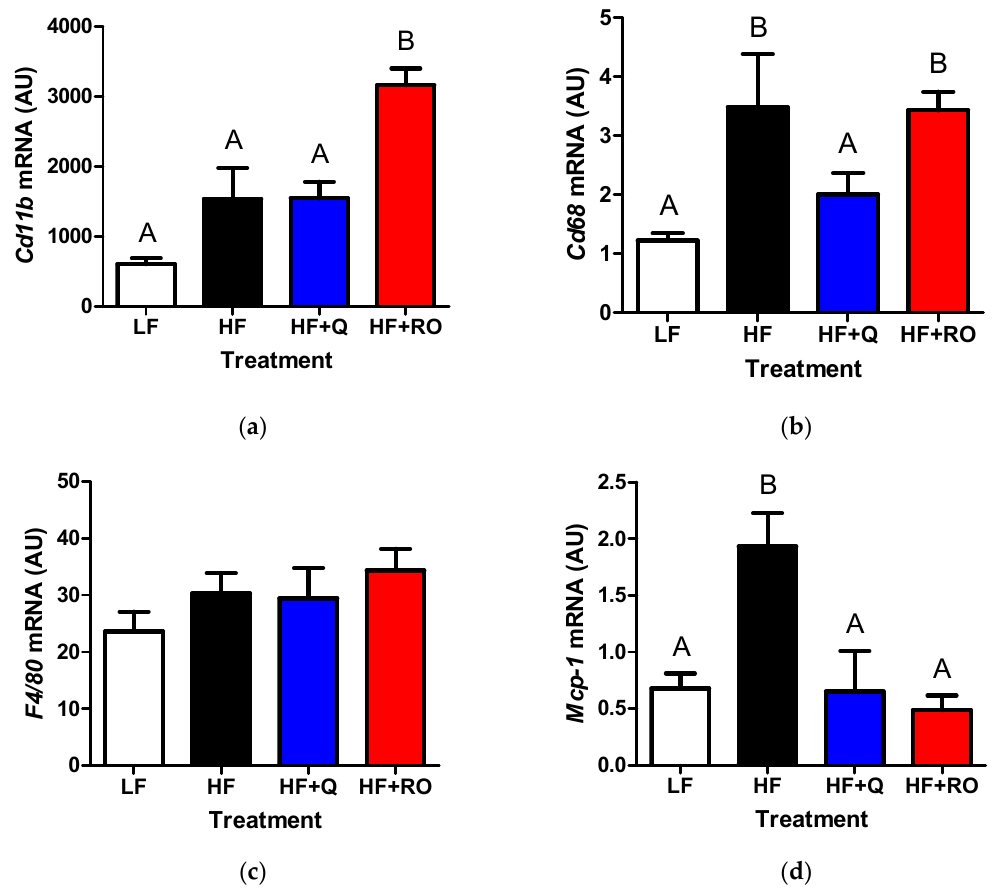
Figure 5. Gene expression for inflammatory markers ( a ) Cd11b ( b ) Cd68 ( c ) F4 / 80 and ( d ) Mcp - 1 were determined in epididymal white adipose tissue (EWAT) from mice were fed low fat (LF; white), high fat (HF; black), high fat + quercetin (HF + Q; blue) or high fat + ROE (HF + RO; red) diets and graphs of respective means ± SEM are shown as arbitrary units (AU). Different letters denote significant differences between groups at p <0.05.